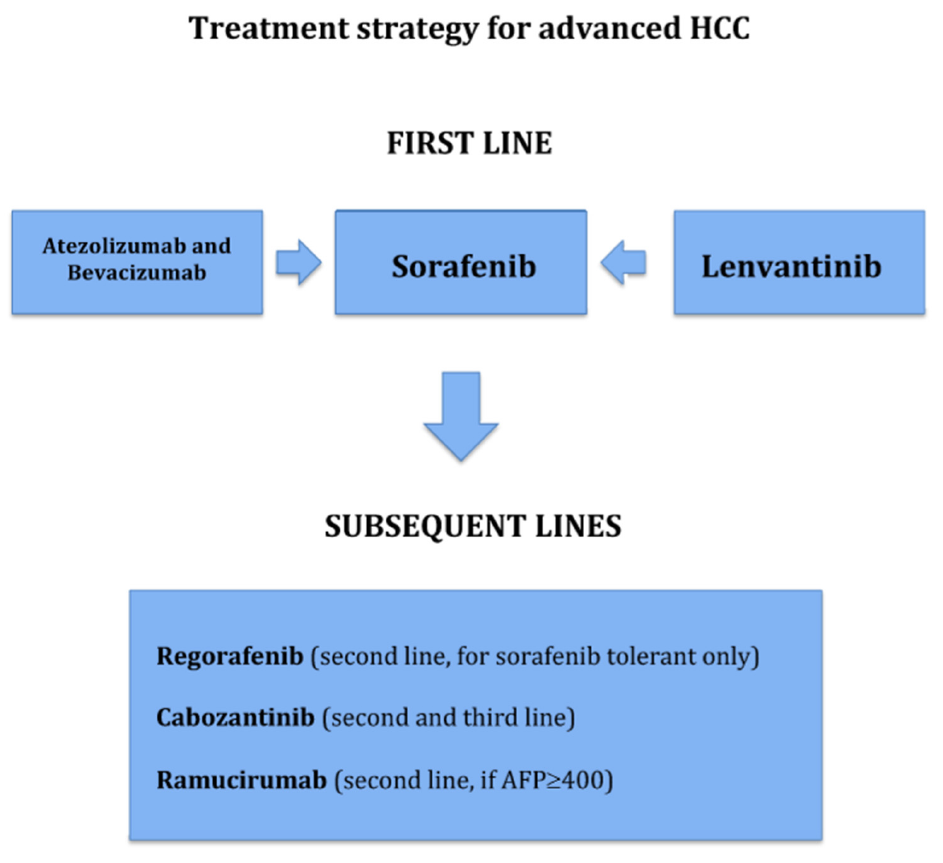
Figure 2. Treatment strategy for advanced HCC: possible therapeutic sequencing. First-line: so- rafenib, lenvantinib, or the combination atezolizumab/bevacizumab. Subsequent lines: regorafenib, cabozantinib, or